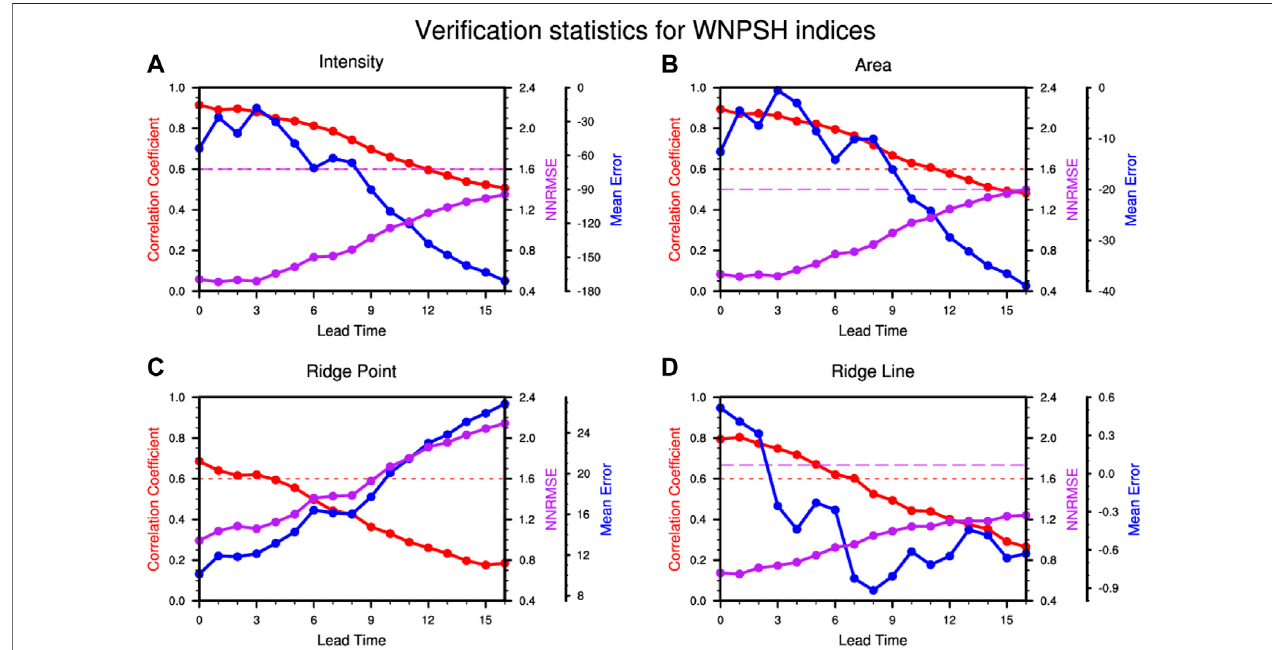
FIGURE2| Veri fi cation statistics asafunctionofleadtime (days), wherered lines representcorrelation coef fi cient ( R ),purplelinesdo normalized rootmean square error ( NRMSE ) and blue lines do mean error ( ME ) for verifying the WNPSH indices of (A) intensity, (B) area, (C) western boundary ridge point and (D) ridgeline by the NCEP-GEFS reforecasts. The red and purple dash lines represent the corresponding thresholds of R and NRMSE , respectively.